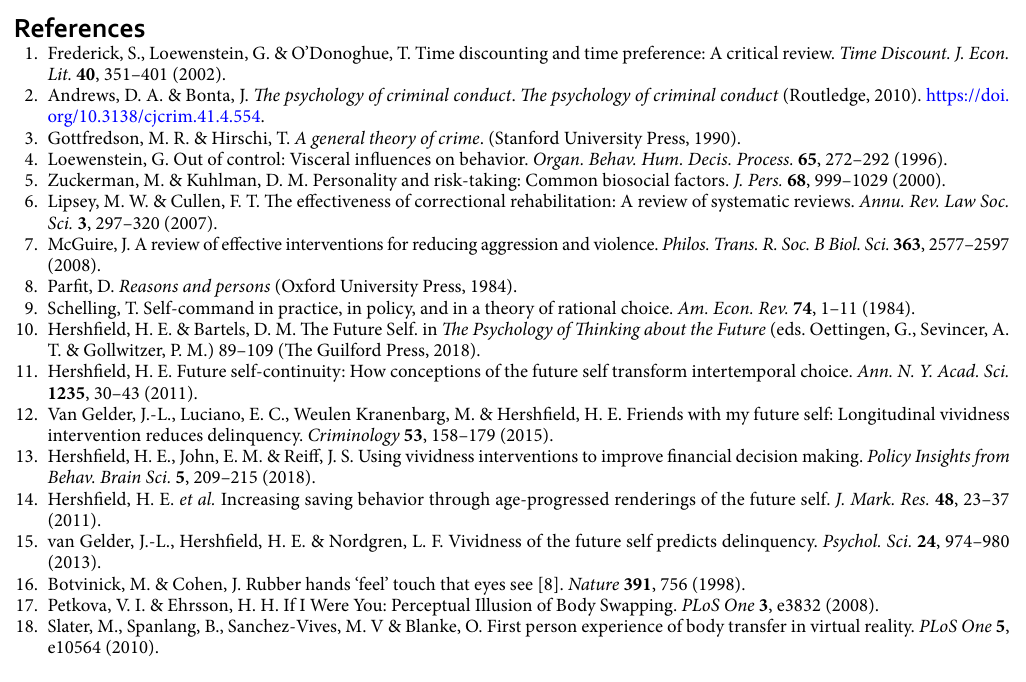
instructed to look into the mirror to their right and saw their aged avatar reflected in it. Subsequently, par- ticipants again performed several movement exercises while looking into the mirror to foster FS embodiment. Participants were then asked to reflect on the cards that they had put in the YES box earlier and sorted these into either a GOOD FOR ME box or a BAD FOR ME box. Once completed, participants time-travelled back to their PS avatar where they saw their ‘future-self score’ reflecting the total number of cards that had been sorted into the GOOD FOR ME and BAD FOR ME boxes by the FS avatar. Next, participants were asked several scripted questions (e.g., “Does your future self benefit from your current lifestyle?”). After a few minutes of reflection, participants time-travelled to embody their FS again to come up with some advice for their PS. This advice was recorded and, once participants switched to their PS for the last time, played back to them. After the VR exercise, participants completed the T2 measures. One week after the VR experiment, partici- pants received an email with a request to complete the follow-up measures (T3) (footnote: Detained participants (n = 4) received a paper version of the follow-up measures by an experimenter. Furthermore, in line with prison regulations, detained participants were not compensated by a €10 gift voucher.). After completing the follow-up measures, participants were debriefed and received a €10 gift voucher.